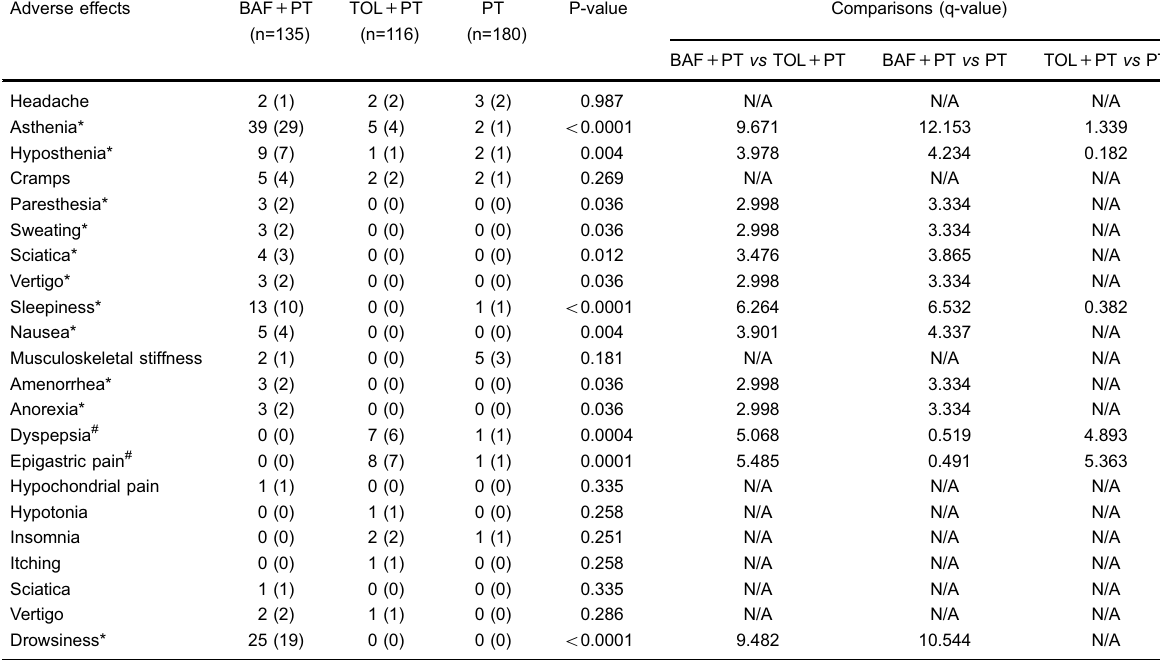
Table 4. Adverse effects during 6 weeks of